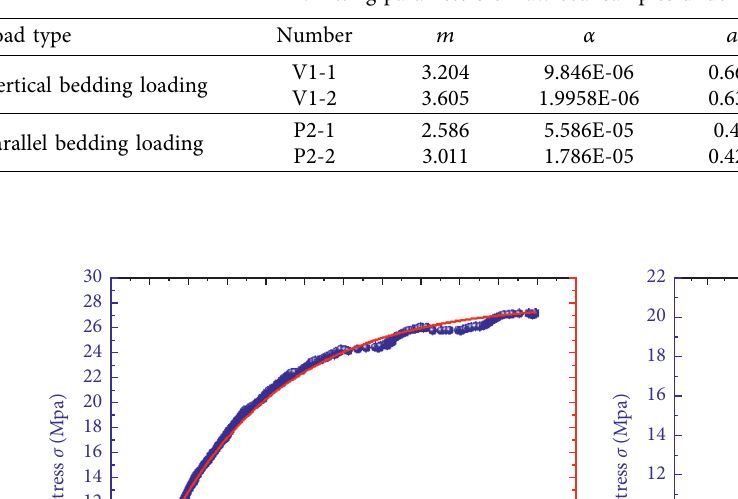
Table 2: Fitting parameters of raw coal samples under different loading modes.